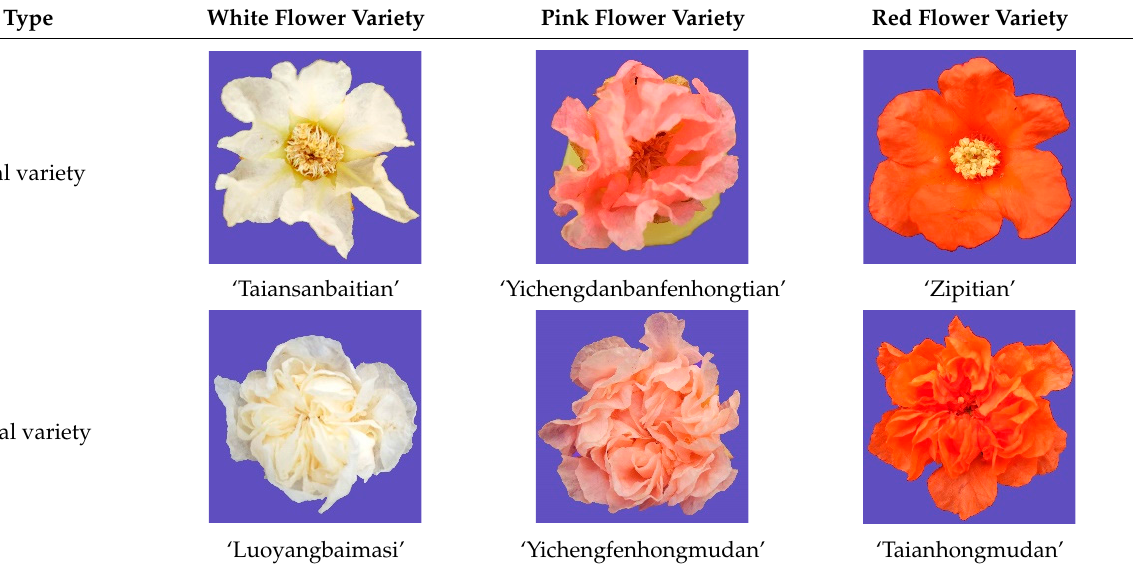
Table 1. Six ornamental pomegranate varieties.